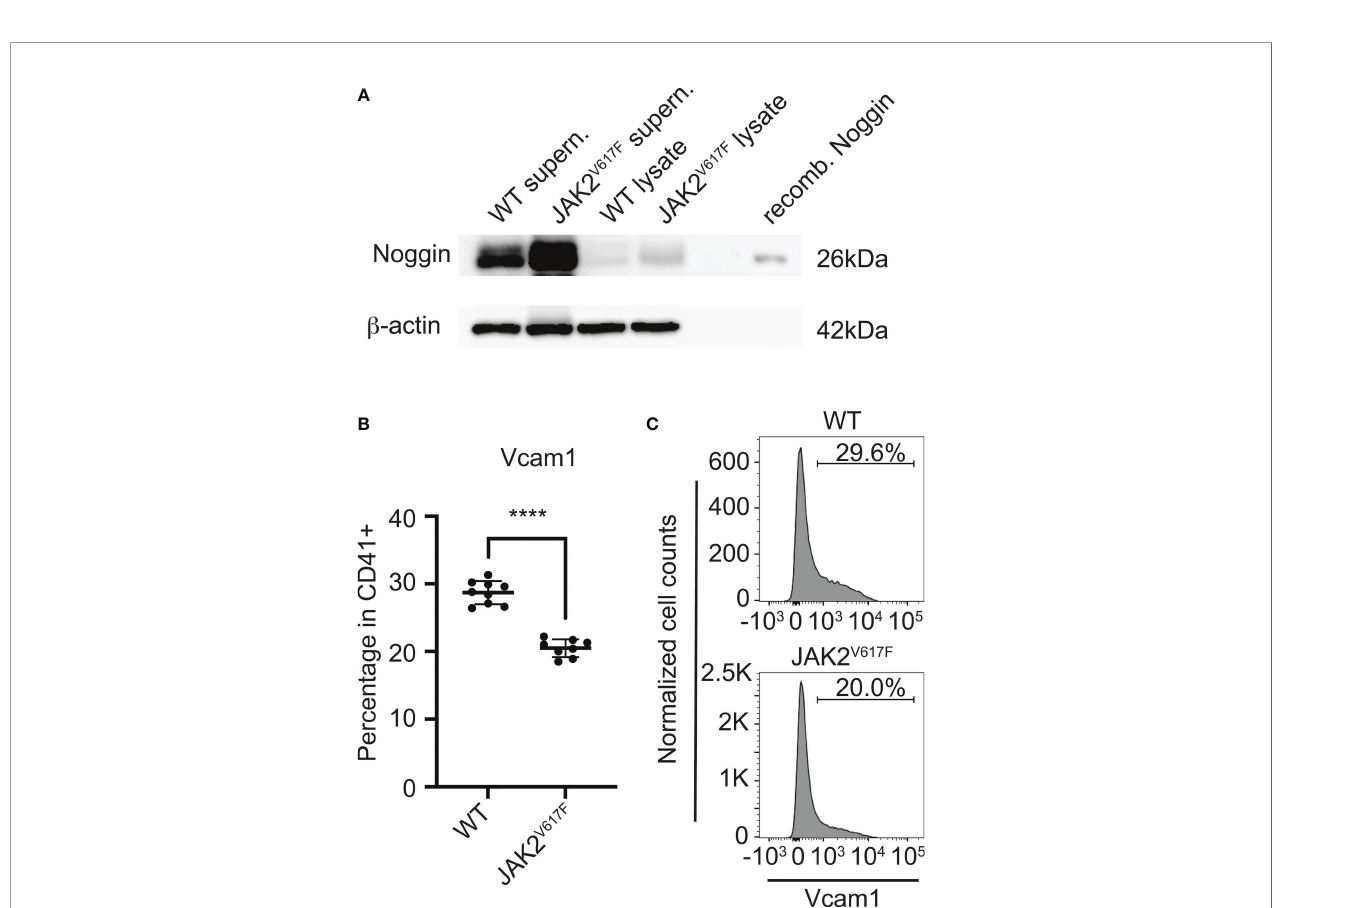
FIGURE 6 | Noggin and Vcam1 proteins are differentially expressed in JAK2 V617F MKs compared to control. (A) Western blotting con fi rmed that the level of cellular and secreted Noggin protein is increased in/by the mutated MKs. Bone marrow cells from JAK2 V617F and WT mice were differentiated towards MKs and puri fi ed as described under methods. MKs were re-plated for another 24h, using the same number of MKs for JAK2 V617F and WT samples. Supernatants were concentrated and subjected to SDS-PAGE together with MK lysates, using also recombinant Noggin protein marker as control. Membranes were probed with anti-Noggin or with anti- b -actin (as loading control). Supern. denotes supernatant and recomb. denotes recombinant. Data are representative of fi ve JAK2 V617F or fi ve matching control 18 weeks old male mice. (B) Flow cytometry analysis showing that Vcam1 protein is signi fi cantly decreased in MKs (CD41+) of JAK2 V617F mice compared to controls. Eight JAK2 V617F male mice and nine control 14 weeks old mice were used. (C) Representative data of fl ow cytometric analysis of Vcam1 expression in MKs shown in (B) . ****Denotes p<0.0001.